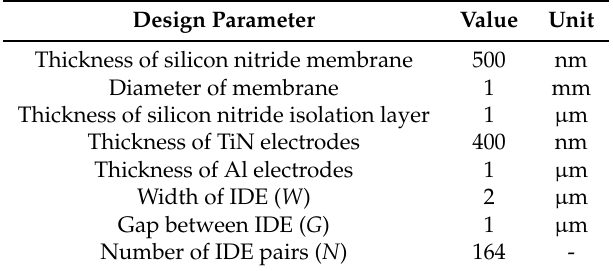
Table 1. Design parameters for fabrication of the devices.